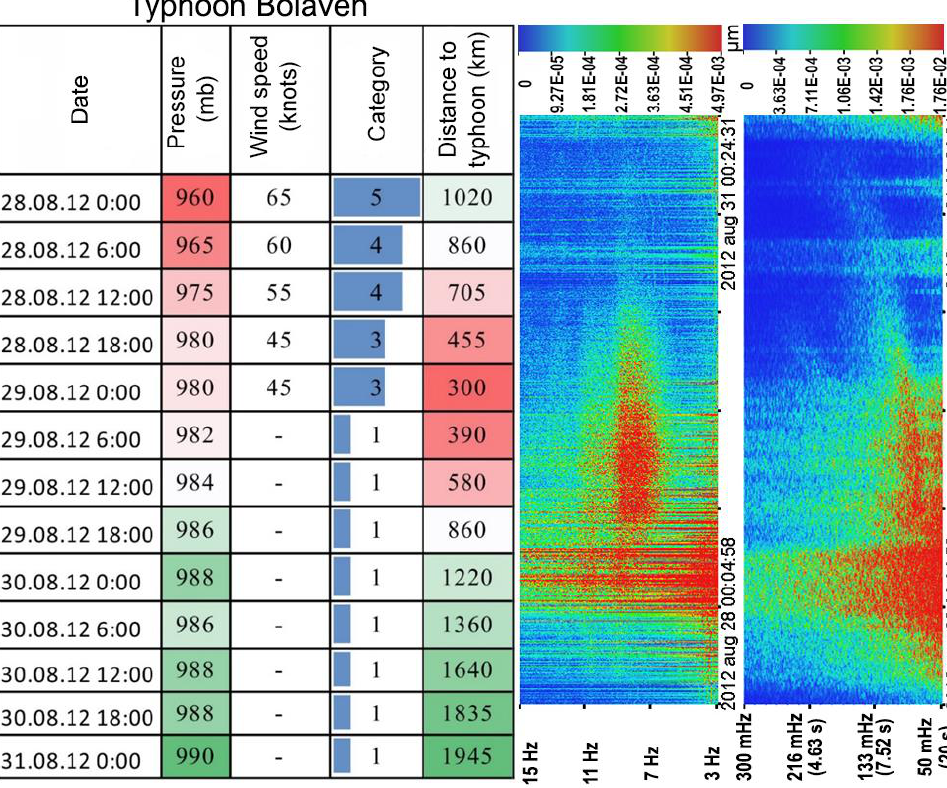
Figure 6. Table of typhoon Bolaven characteristics ( left ) and dynamic spectrograms of laser strain- meter during its impact ( right ).